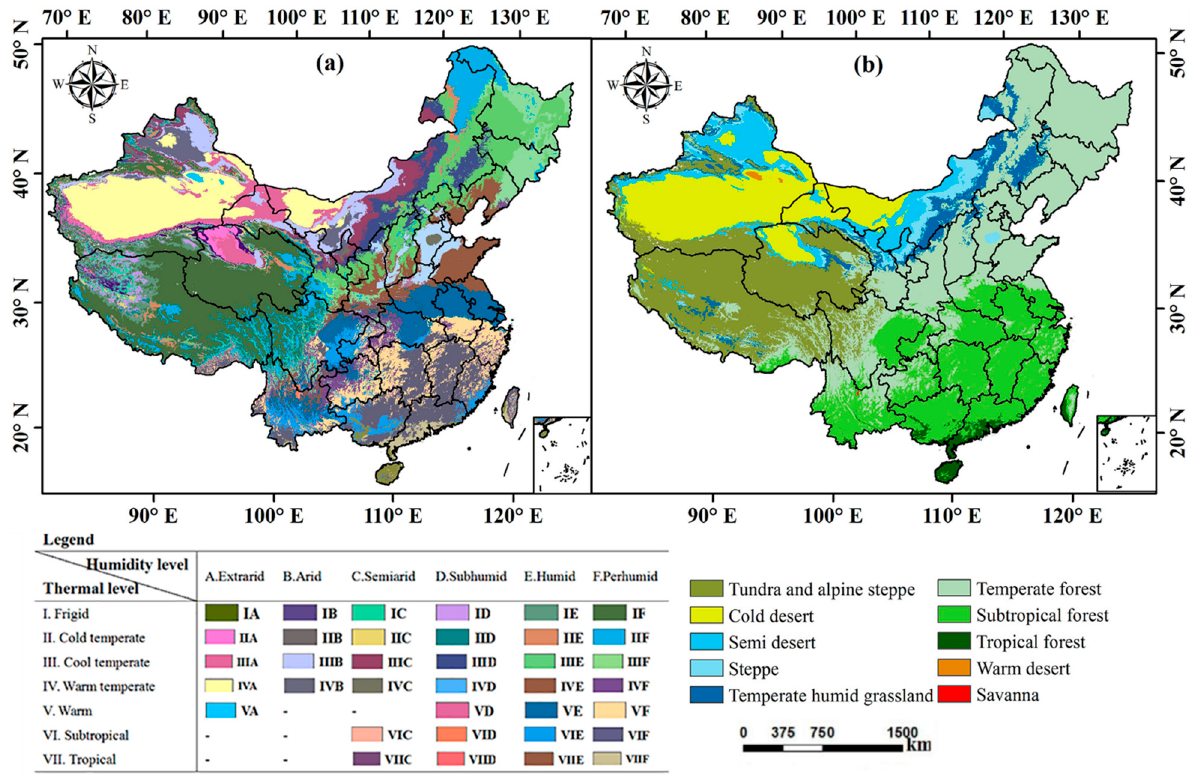
Figure 4. Spatial distribution of PNV ( a ) and super-classes ( b ) in the baseline scenario.